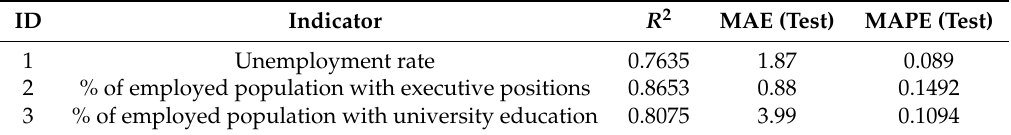
Table 6. Model effectiveness for three different Socio-Economic Status (SES) indicators. ID Indicator R 2 MAE (Test) MAPE (Test) Unemployment